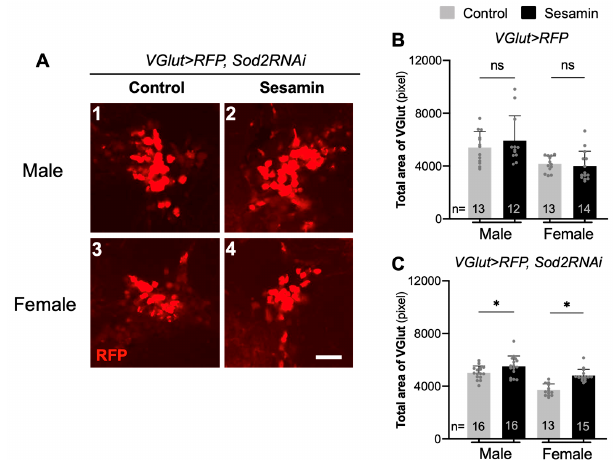
Figure 5. Suppression effects of sesamin on the oxidative stress-induced reduction of areas occupied by glutamatergic neurons in adult brains harboring the neuron type-specific depletion of Sod2 . ( A ) In glutamatergic neurons labelled in red by RFP expression, the neuron-specific depletion of Sod2 mRNA was carried out ( VGlut > RFP , Sod2RNAi ). Only a basal level expression of VGlut > RFP was observed in clusters of glutamatergic neurons in male brains ( A1 ) and female brains ( A3 ) from flies fed on the control diet, while feeding of the diet with sesamin at 2 mg/mL enhanced the RFP fluorescence in both male ( A2 ) and female brains ( A4 ). ( B , C ) Total area occupied by the cholinergic neurons in the brain ( VGlut > RFP ) ( B ), or in brains harboring glutamatergic neuron-specific ROS accumulation due to the Sod2 depletion ( VGlut > RFP , Sod2RNAi ) ( C ), from adults ( n ≥ 12 each). Brains were prepared from the male or female flies fed on a diet either with 0.5% DMSO only (control), or with sesamin at 2 mg/mL in 0.5% DMSO (sesamin) for 7 days. Scale bar represents 10 µ m. Student’s t -test, ns not significant, * p <